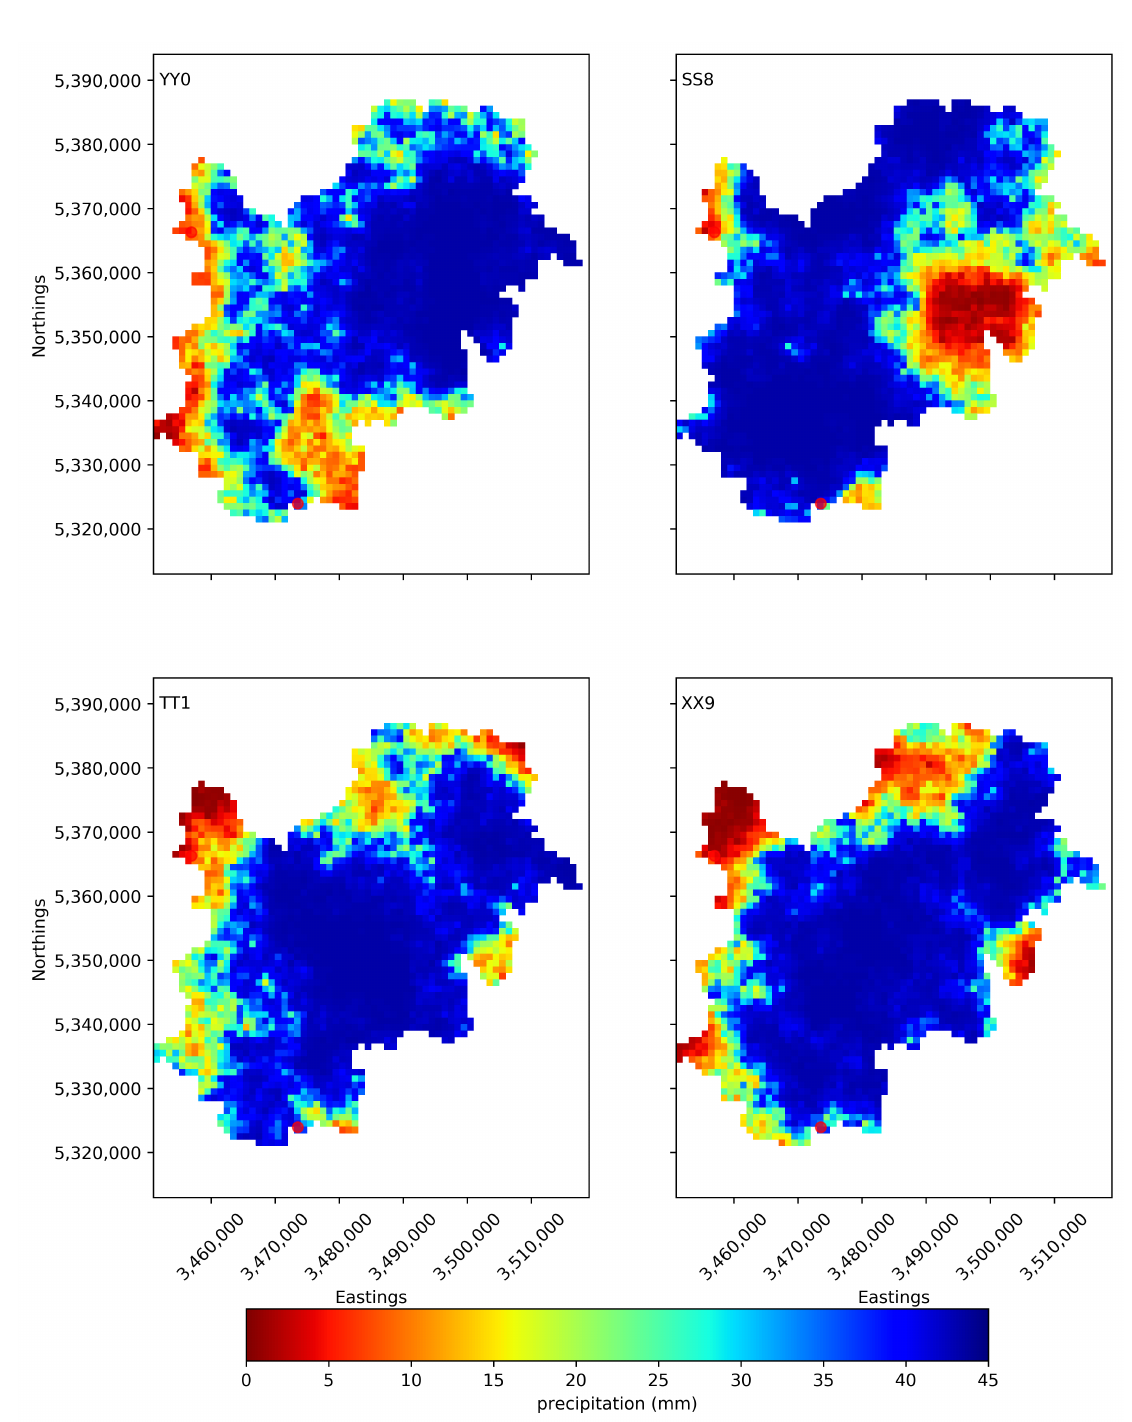
Figure 10. Gridded inverted precipitation fields for 24 December 1882. The upper two panels show the most dissimilar simulated pair, the lower the most similar